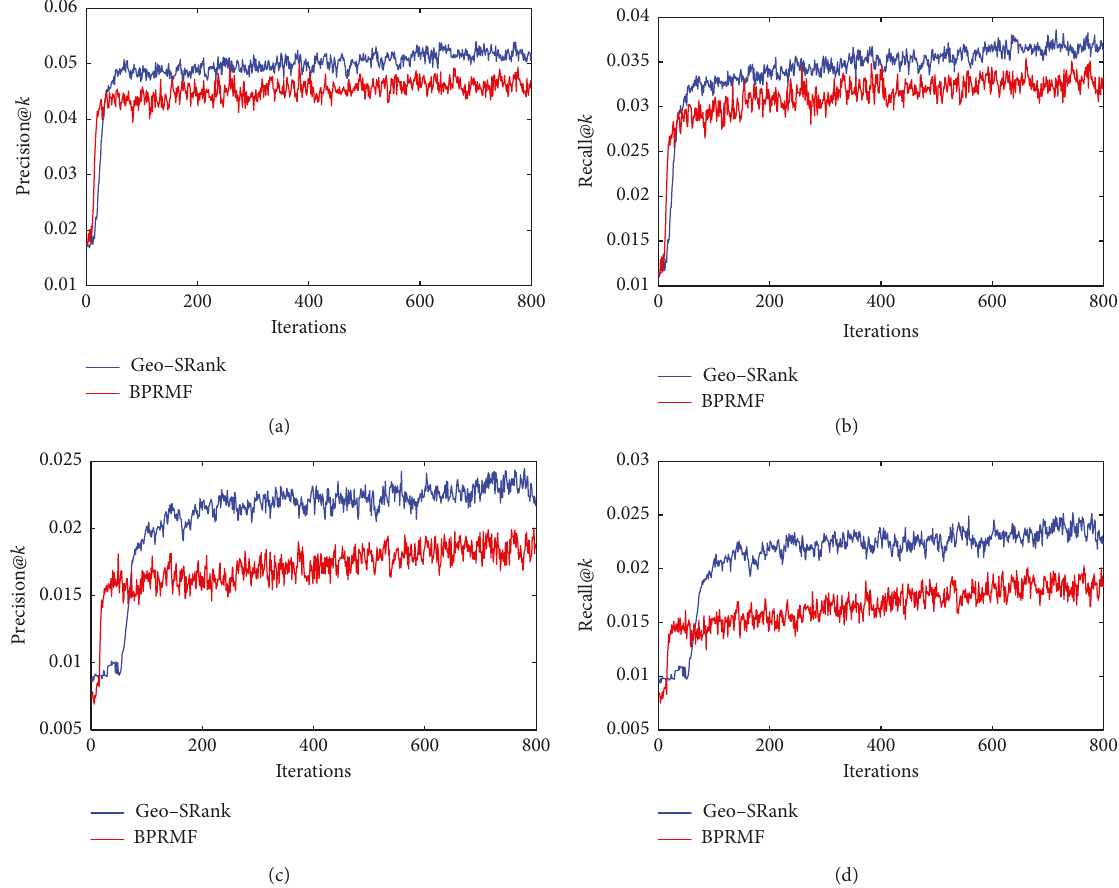
Figure 9: The experimental results with training iterations on the cold-start data. (a) Precision@ k on Gowalla, (b) Recall@ k on Gowalla, (c) Precision@ k on Yelp, and (d) Recall@ k on